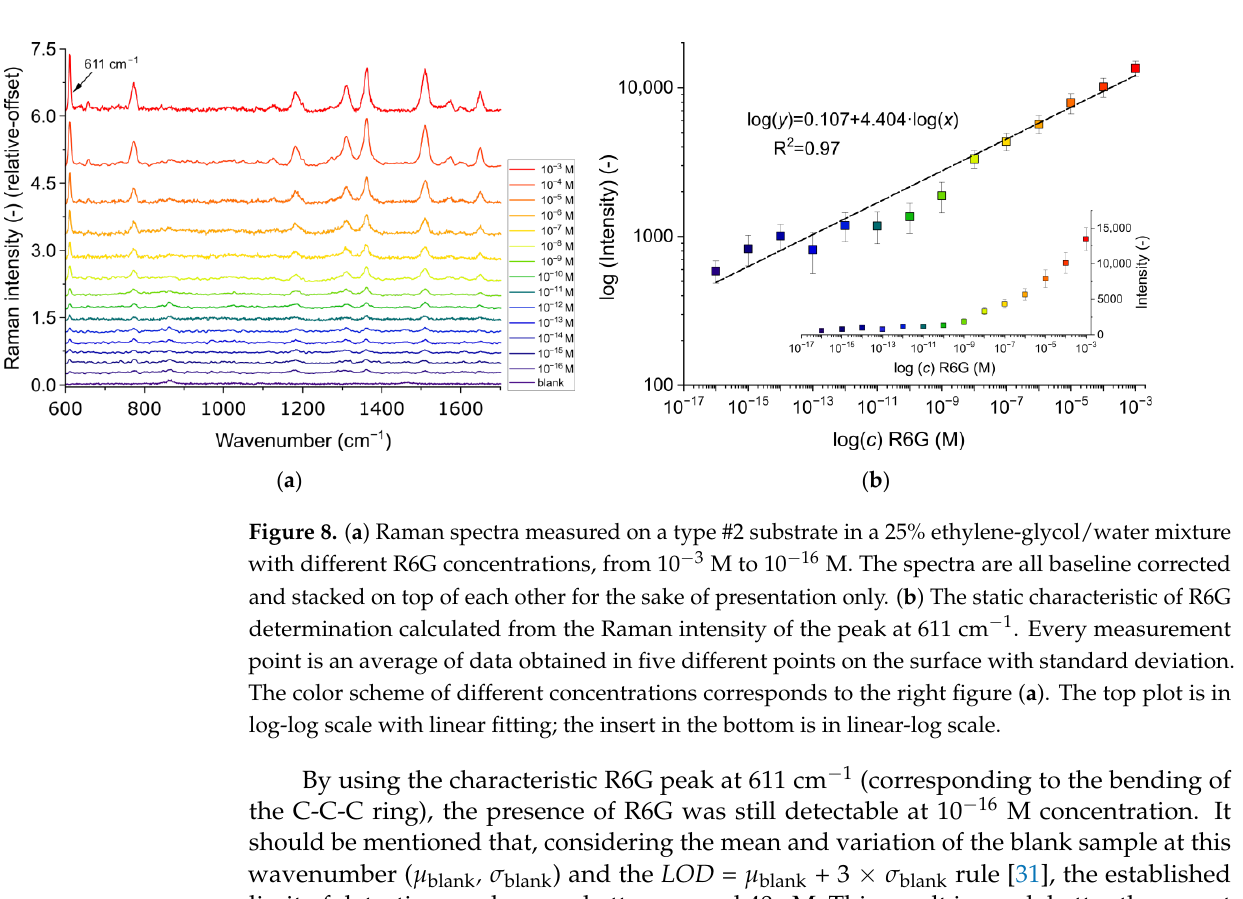
signals and sub-optimal sensing performance. Table 2. Comparison of LOD of R6G detection for different SERS substrates.